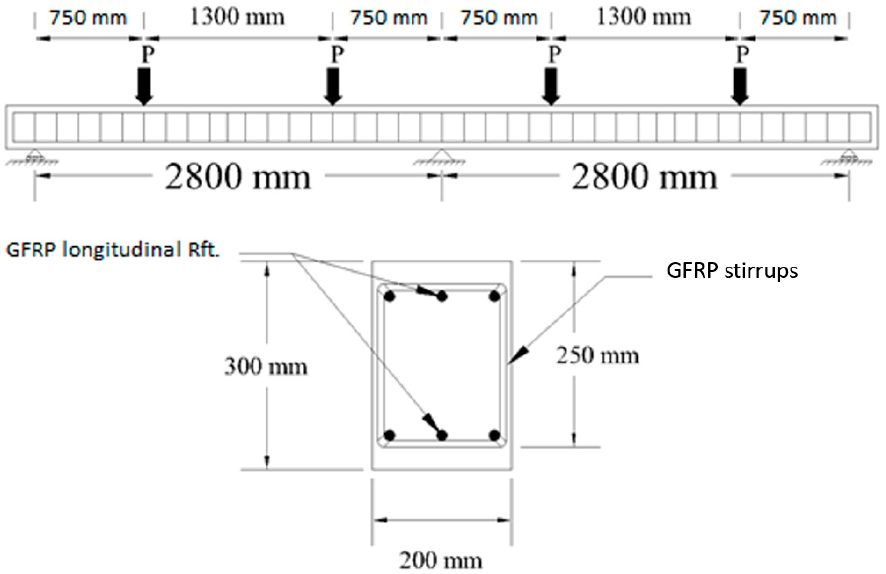
Figure 3. Dimensions, reinforcement details, and test setup of the beams used for verification by FEM.